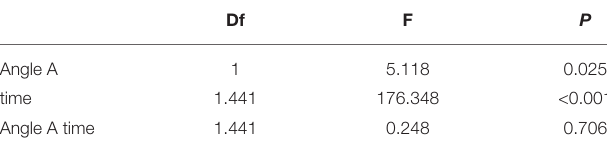
TABLE 4 | Trends in scores for the high and low-risk groups of Angle A at three postoperative time